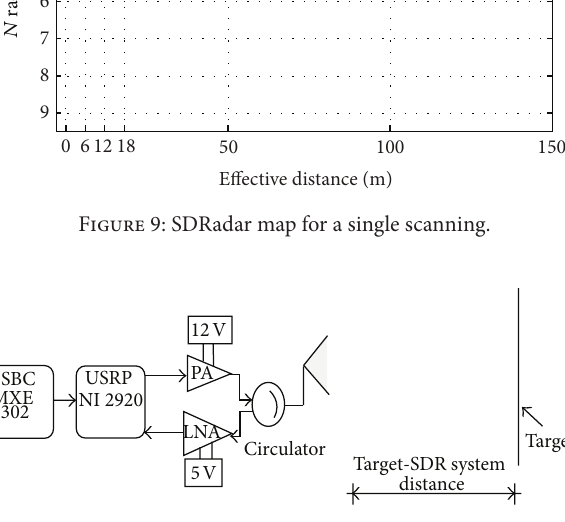
Figure 10: Scheme of indoor test setup.